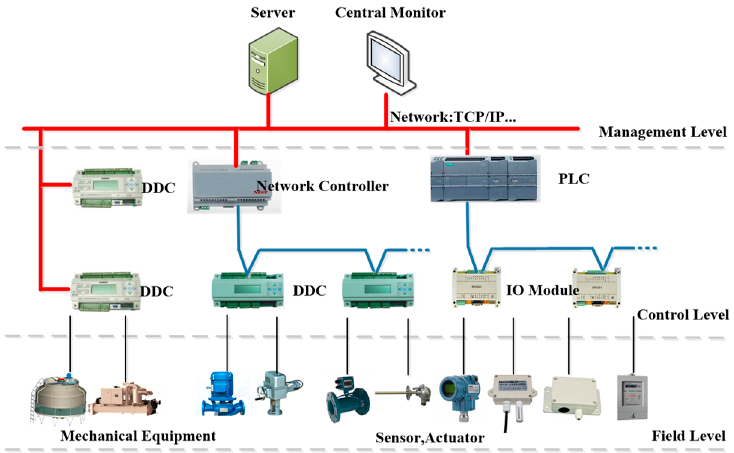
Figure 1. Typical control system structure for chiller plant system.